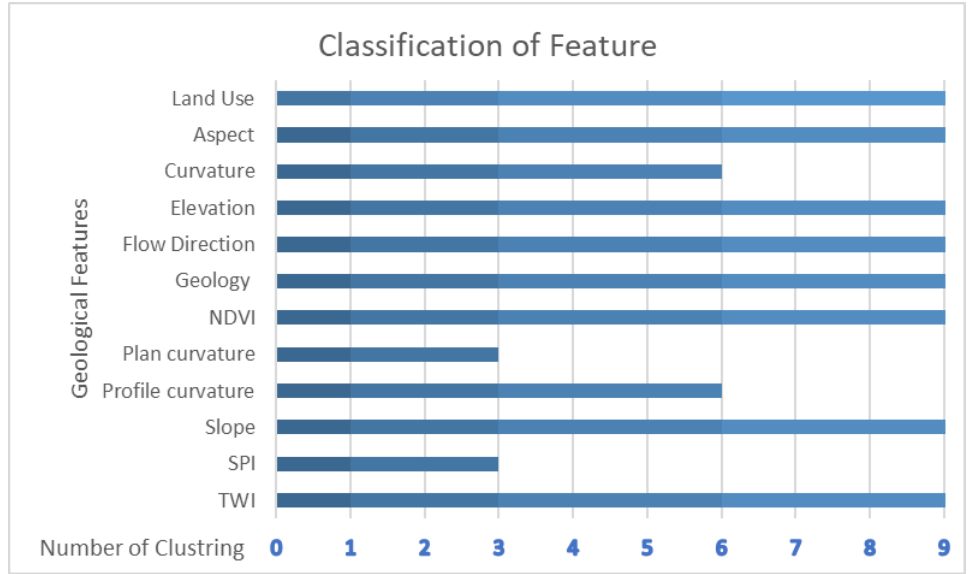
Figure 2 . Classification of Features to use for GCN and other machine learning algorithms (X Axes: Number of